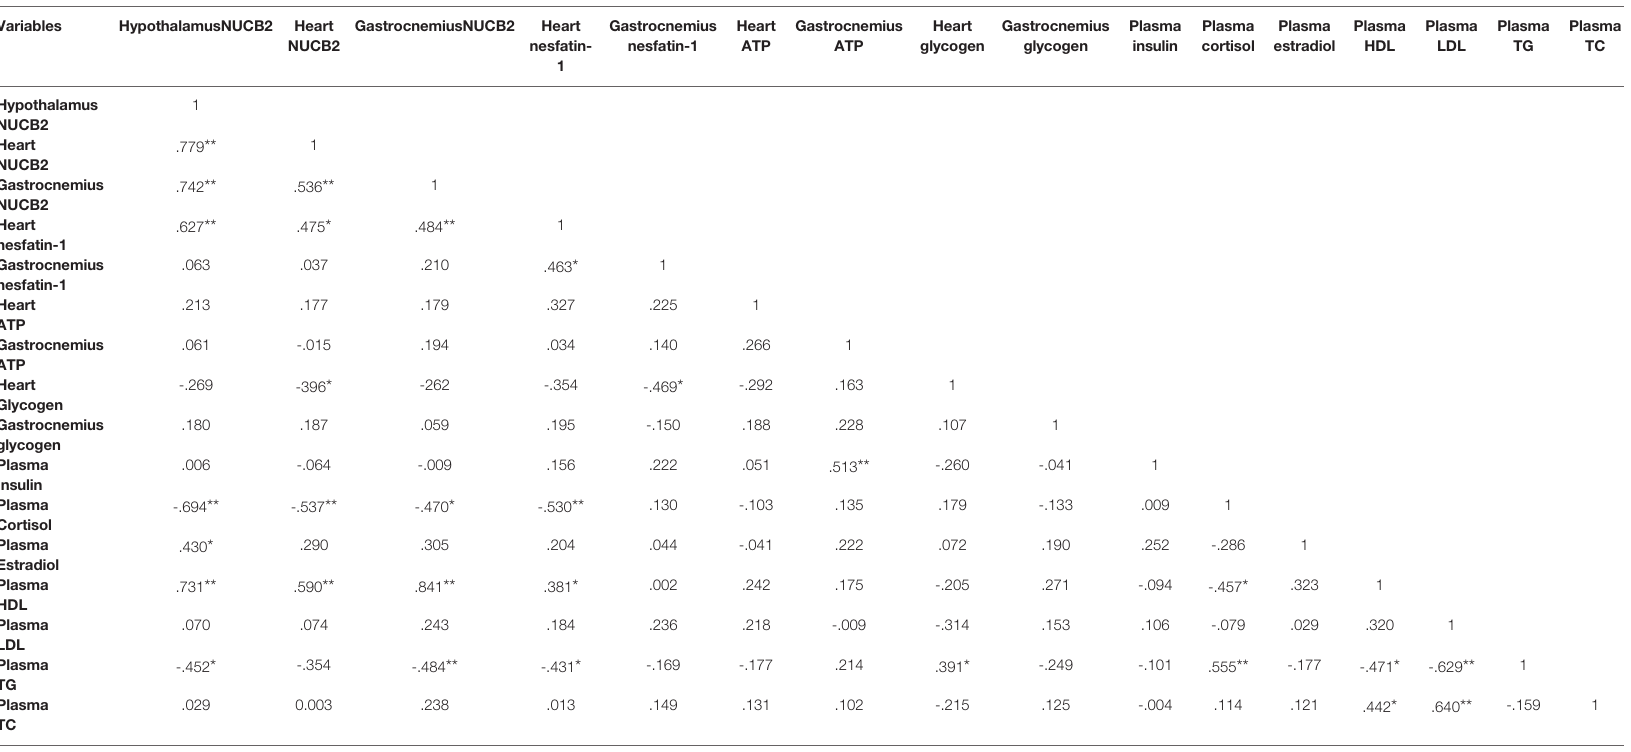
TABLE 1 | The correlation between variables.